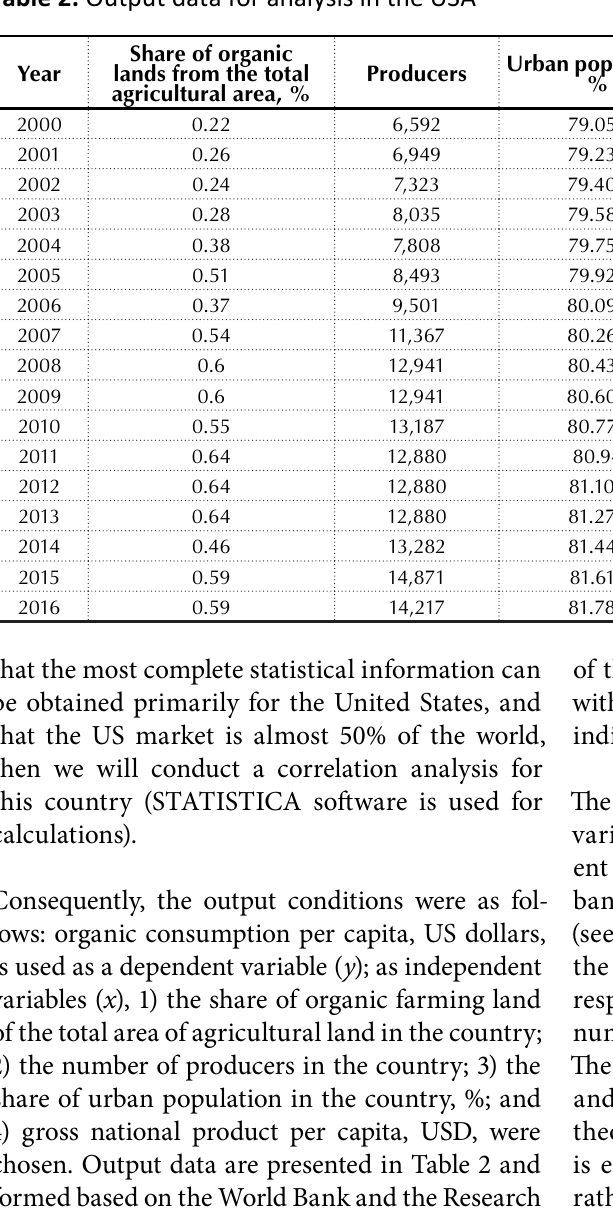
Table 2. Output data for analysis in the